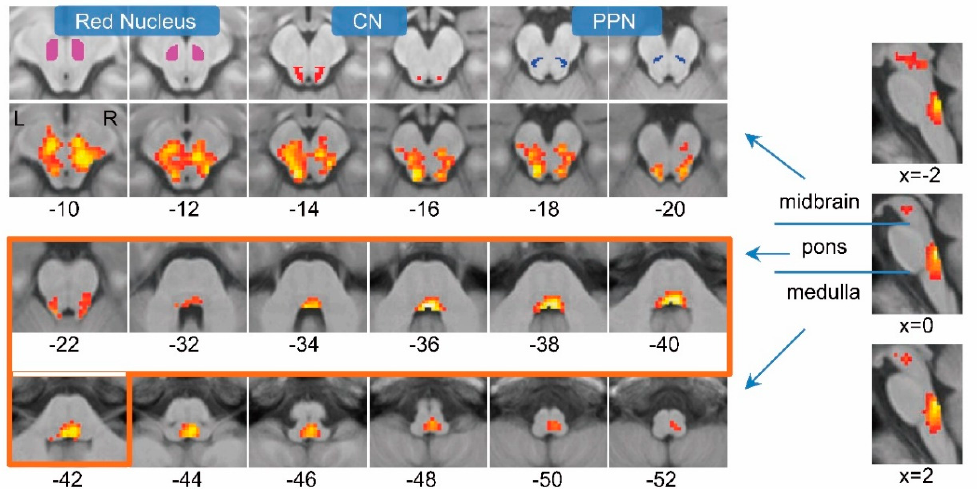
Figure 1. Brainstem activation during the changing-speed locomotion task. Brainstem activation is projected onto the mean T1 image. The numbers in the x-axis (for the sagittal plane) or the z-axis (for the axial plane) indicate the MNI coordinate. The images of the pons are framed in orange.